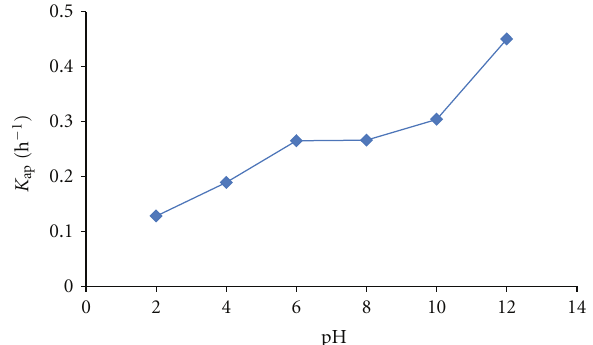
Figure 5: Changes of the apparent aniline photocatalytic reaction constant K ap at di ff erent pH (catalyst concentration: 60mg/L, temperature ( T ): 293 K, and irradiation time: 2h).